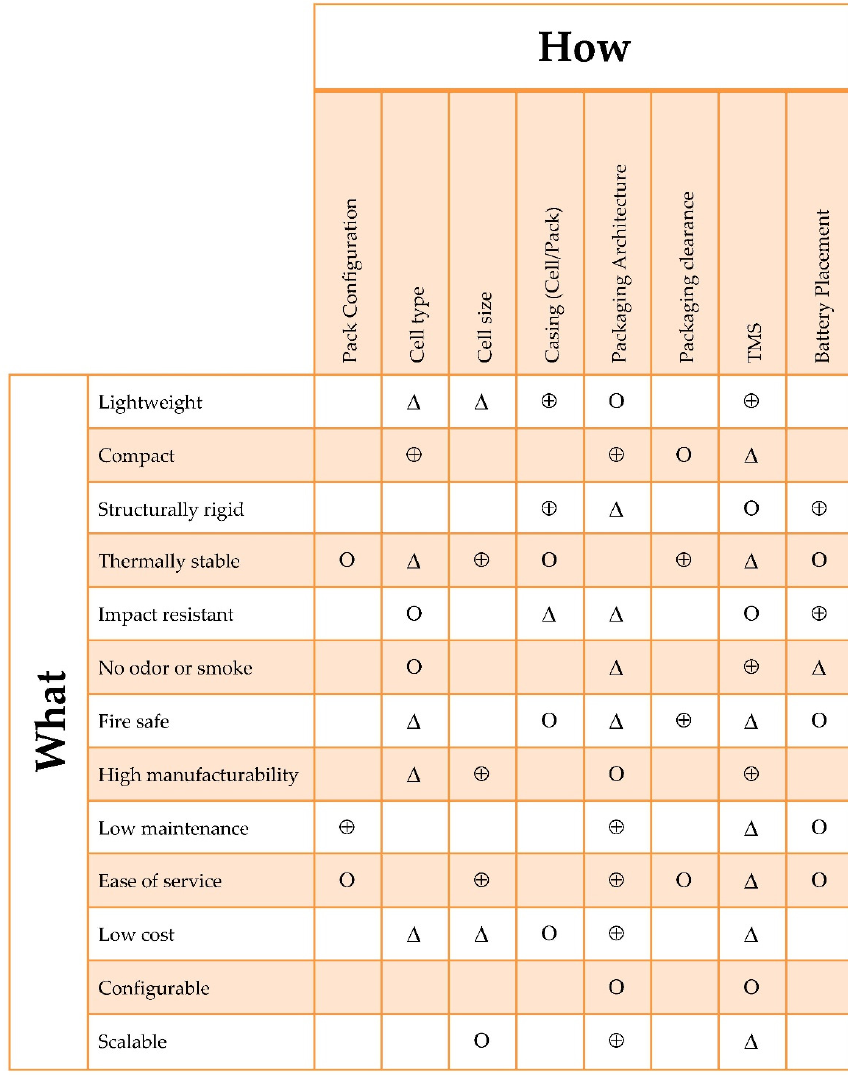
Figure 9. The House of Quality for an EV battery pack (Symbols, (cid:13) , ⊕ and ∆ denote weak, moderate, and strong correlation, respectively).